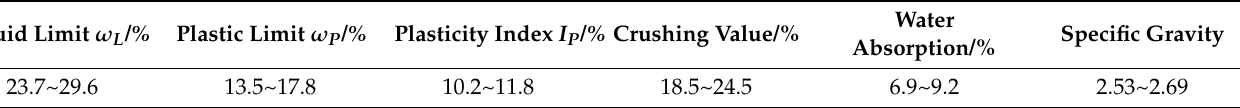
Table 2. The basic physical properties of aggregates recycled from